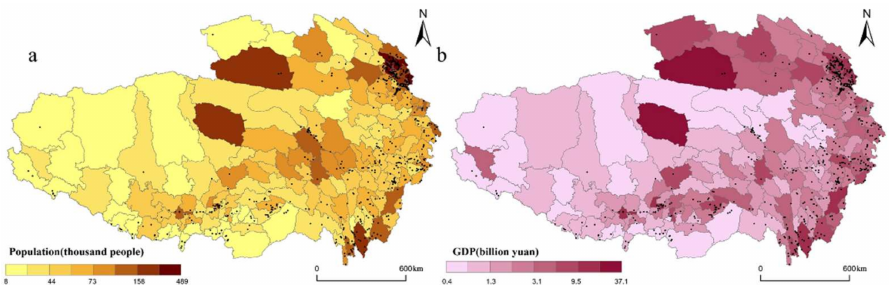
Figure 11. Spatial distribution of RT villages coupled with socio-economic: ( a ) population size; ( b ) the level of economic